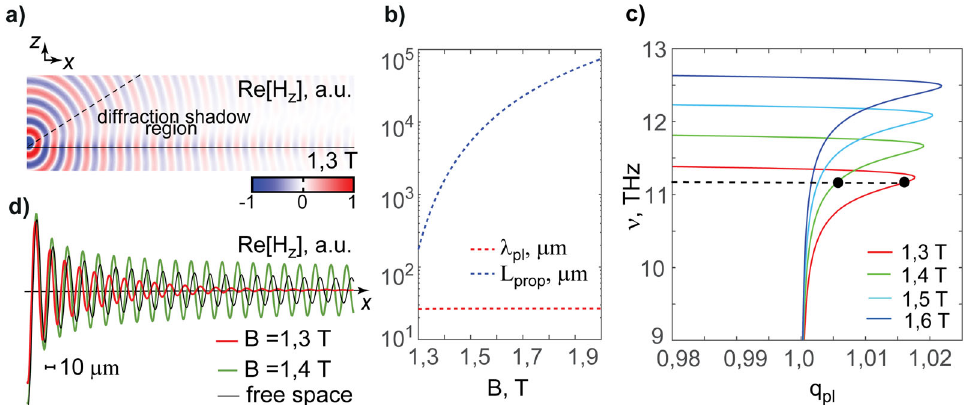
Fig. 3 Dependence of the properties of transverse electric graphene plasmon-polaritons (TE GPPs) in charge neutral graphene (CNG) on magnetic fi eld, B . a Snapshot of the vertical component of the magnetic fi eld of a TE GPP in magnetized CNG, at B = 1.3 T . b Propagation length and wavelength of the TM GPP in magnetized CNG as a function of the magnetic fi eld. c Dispersion relation for TE GPP in magnetized CNGs, calculated for different magnetic fi elds. d Real part of the z-component of magnetic fi eld calculated for both B = 1.3 T and B = 1.4 T (the corresponding GPP wavelengths are λ and λ pl = 26.66 μ m, respectively). For comparison, the free-space wave oscillation (with wavelength λ 0 ) is shown by the black curve. In all panels the frequency v = 11.2 THz ( λ 0 = 26.77 μ